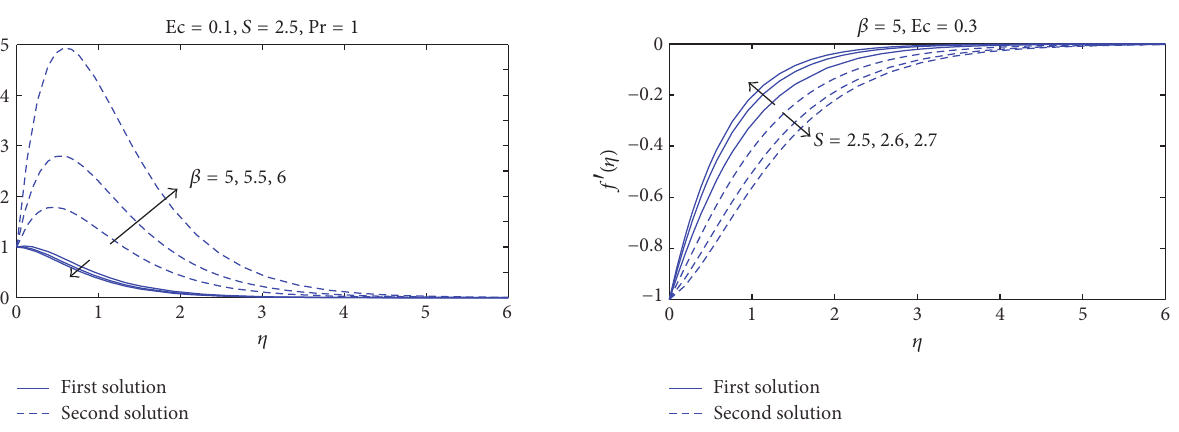
Figure 9: Temperature profiles for different values of 𝛽 .